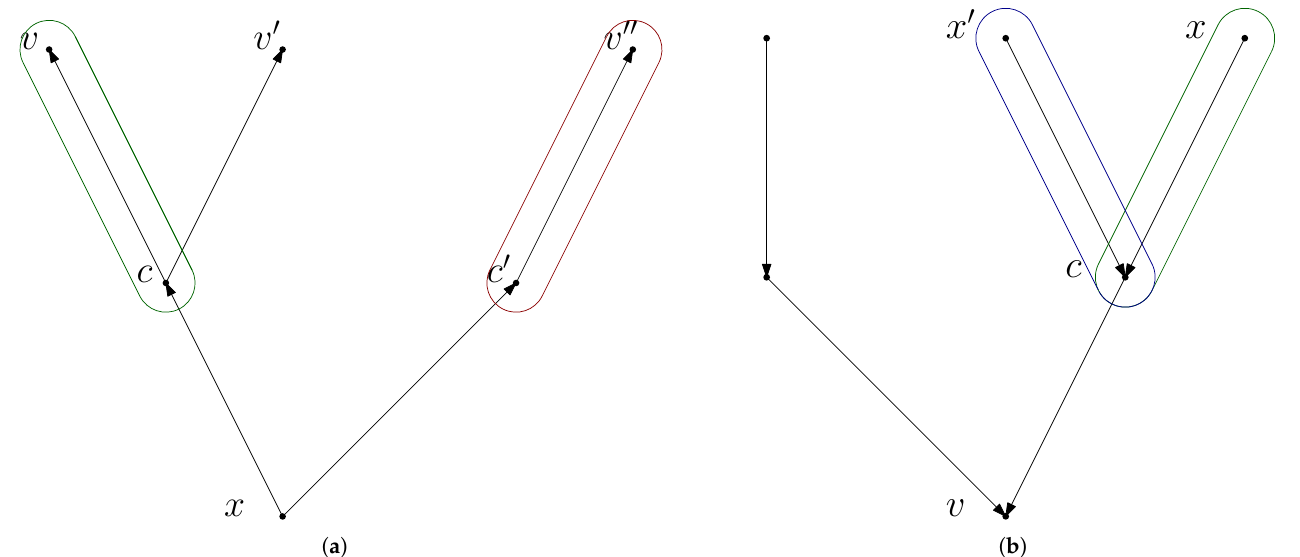
Figure 7. Examples for witness triples in shortest path trees. ( a ) Forward shortest path tree SPT → ( x ) : The witness triple ( x , c , v ) where the relevant nodes for the conflict check are in the green bubble. There is no conflict with ( x , c , v (cid:48)(cid:48) ) and its relevant nodes in the red bubble; ( b ) SPT ← ( v ) : The green witness triple ( x , c , v ) of the left Figure shown in the backward tree of v . It is in conflict with the blue triple ( x (cid:48) , c , v ) because they share the node c